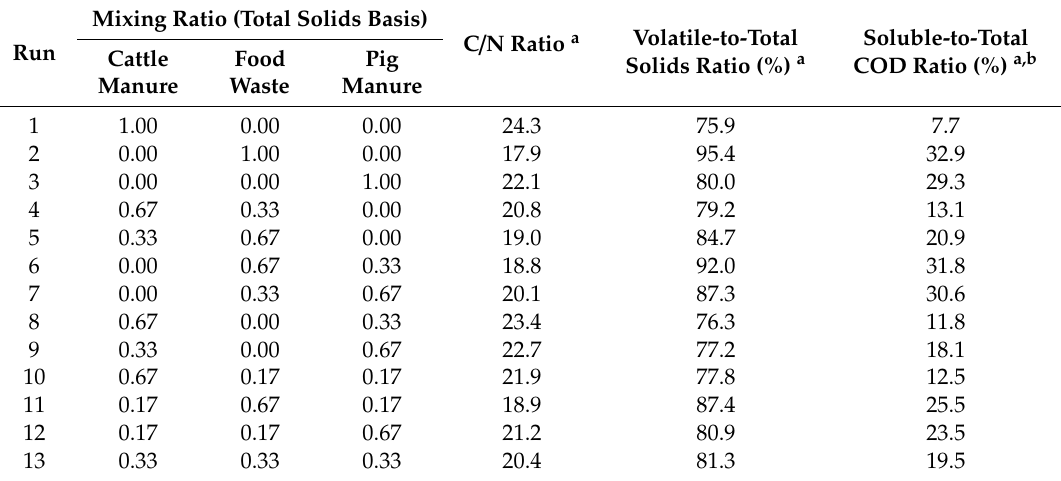
Table 2. Composition and characteristics of substrate